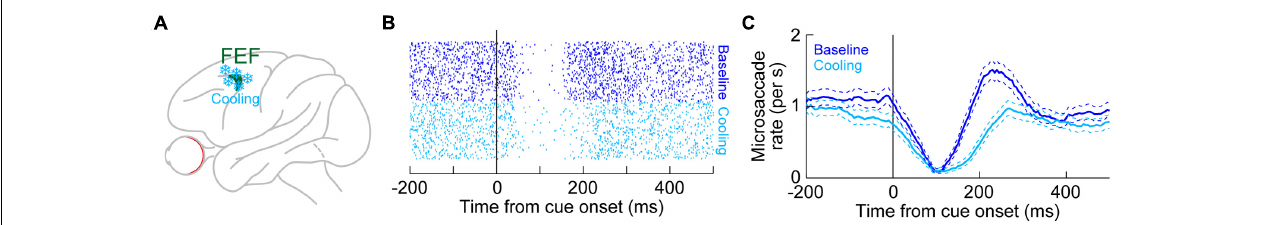
FIGURE 6 | Reversible inactivation of the FEF, through cryogenic techniques, strongly influences microsaccade rate in the post-inhibition rebound phase. (A) Large portions of the FEF (either unilaterally or bilaterally) were reversibly inactivated by cooling of neural tissue. (B) Microsaccade onset times across trials (each row of rasters represents an individual trial) in baseline (blue) or with unilateral FEF inactivation (light blue). The task consisted of fixation with the onset of a peripheral spot in the affected hemifield. In baseline, there was expected microsaccadic inhibition shortly after cue onset, followed by a rebound in microsaccade likelihood. With FEF inactivation, microsaccadic inhibition still occurred, and with similar latency to baseline. However, the post-inhibition rebound was strongly impaired, resulting in an appearance of prolonged microsaccadic inhibition. (C) Microsaccade rate estimates for the data in (B) . Microsaccadic inhibition still clearly happened with or without FEF inactivation. However, microsaccadic rebound only happened when the FEF was intact (baseline). (B,C) Adapted with permission from Peel et al.